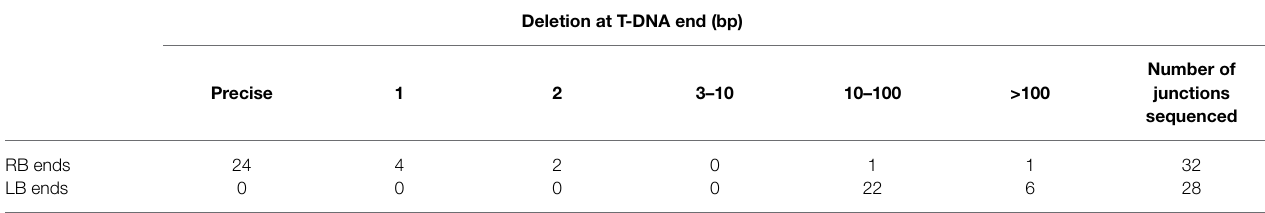
TABLE 2 | Summary of extent of deletions in T-circle heterodimers at the RB and LB ends of RB-RB and LB-LB junctions isolated from Nicotiana benthamiana . Deletion at T-DNA end (bp)